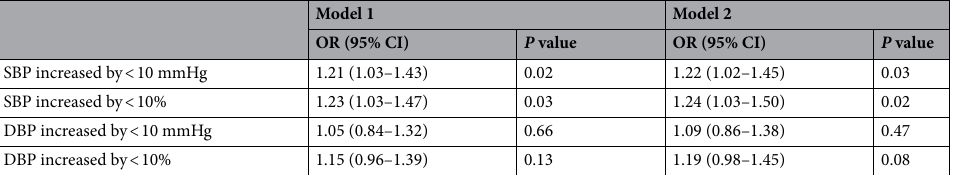
Table 5. Estimated odds ratios (ORs) and 95% confidence intervals (95% CI) of loss of longitudinal blood pressure (BP) increase over the first 3 years for incident dementia at Years 4 to 6. Model 1 was unadjusted, whereas Model 2 was adjusted for age, sex, educational level, socioeconomic status, history of hypertension, diabetes, hypercholesterolemia, obesity, heart diseases, visual impairment, hearing impairment, poor balance, depression, physical exercise, intellectual activities, social activities, fruit and vegetable consumption, smoking, alcohol use, hypertension, hypotension, and blood pressure